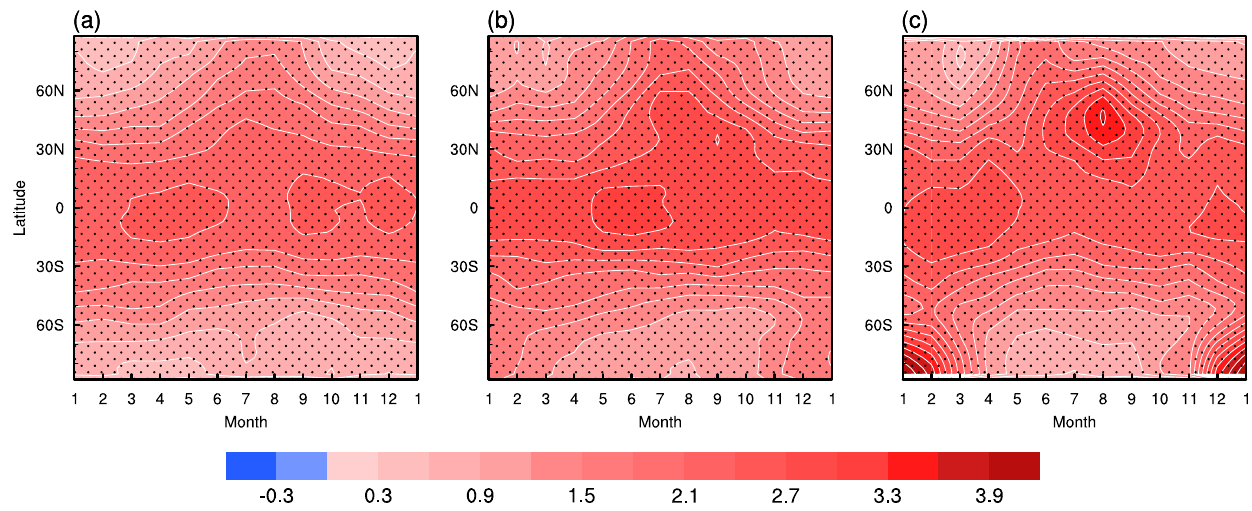
Fig. 7. Latitude-month plots of zonal-mean temperature trends at 300hPa over 2001–2050. (a) AR4-NO-O 3 , (b) AR4-O 3 and (c) CCMVal-1 models. Colour interval is 0.30K per 50yr.